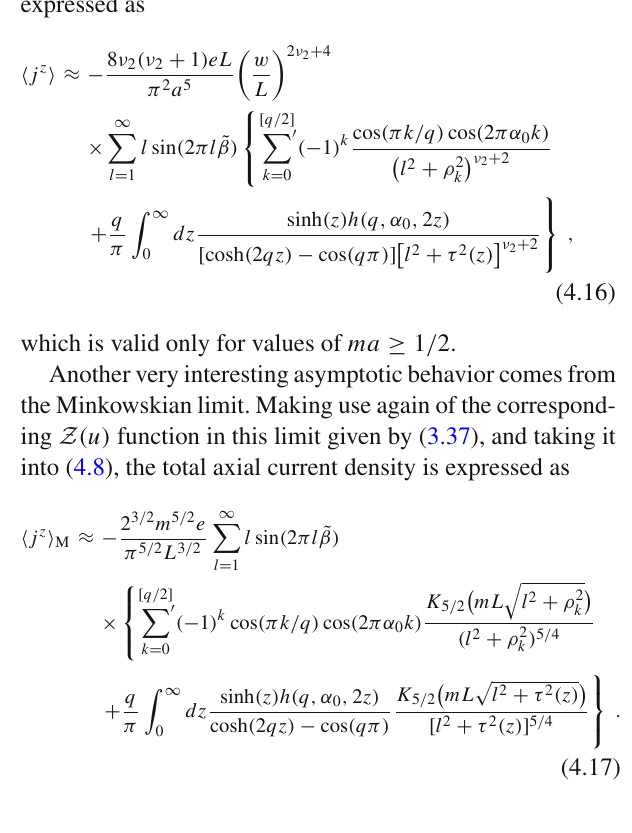
the compact dimension, L /w (cid:13) 1, the total axial current is expressed